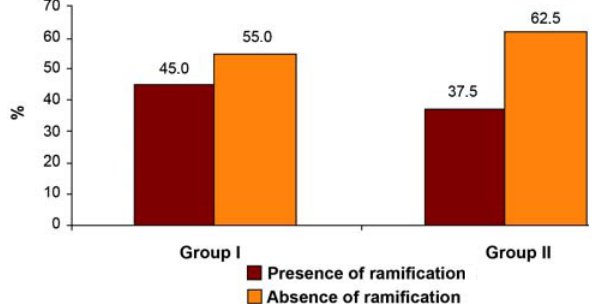
FIGURE 2- Ramifications observed in Groups I and